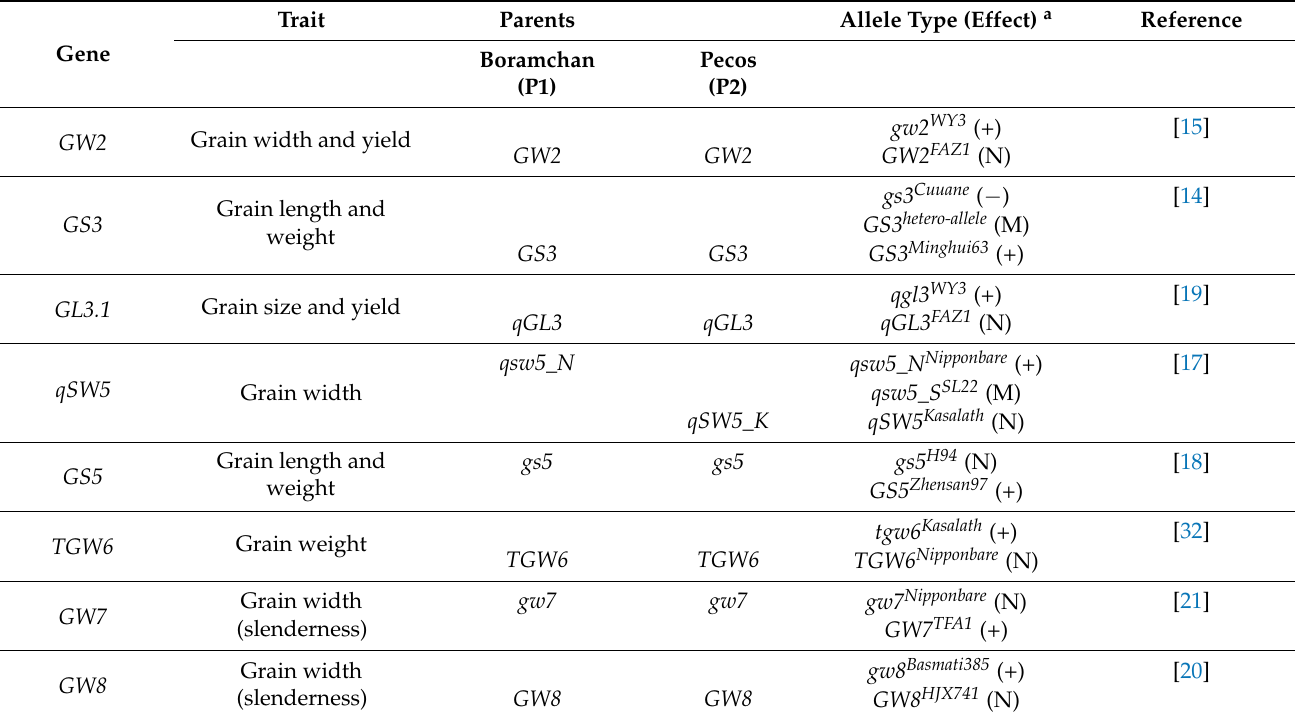
Table 3. Haplotype test for the parents, Pecos and Boramchan, using eight specific DNA markers to characterize genes associated with grain shape.